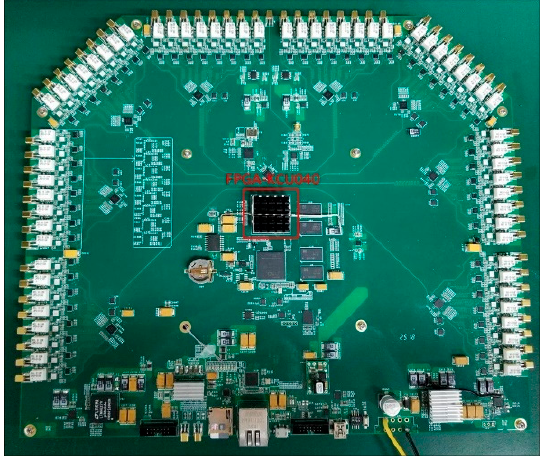
Figure 12. A 64-channel correlation module performing cross-correlation processing and power detection.